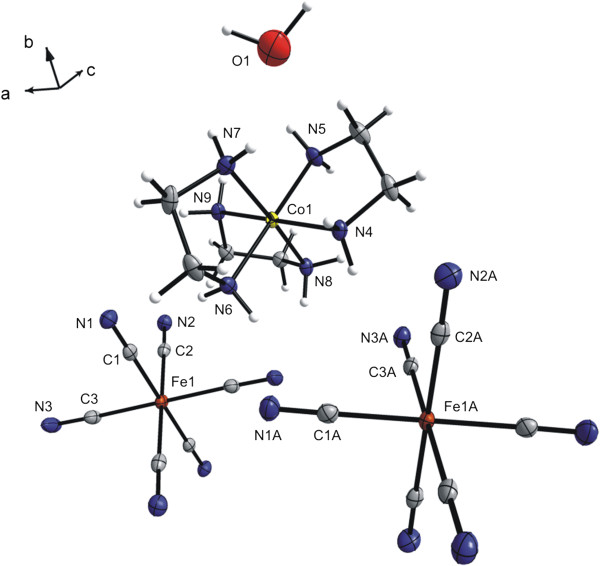
Molecular structure of [Co(en)3][Fe(CN)6]⋅ 1/2H2O (1b). The thermal ellipsoids are drawn at the 50% probability level.